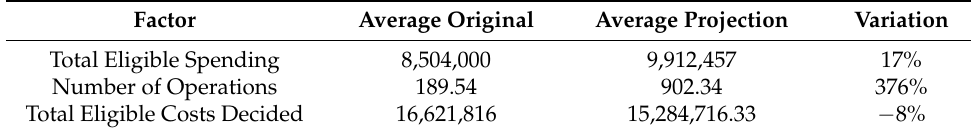
Table 8. Improvement potential for the